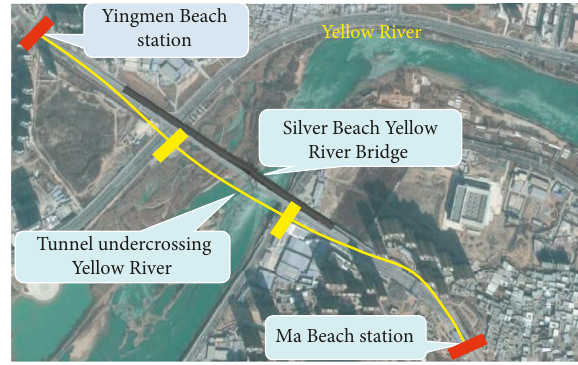
Figure 1: Plane layout of the Lanzhou No.1 Metro Line.